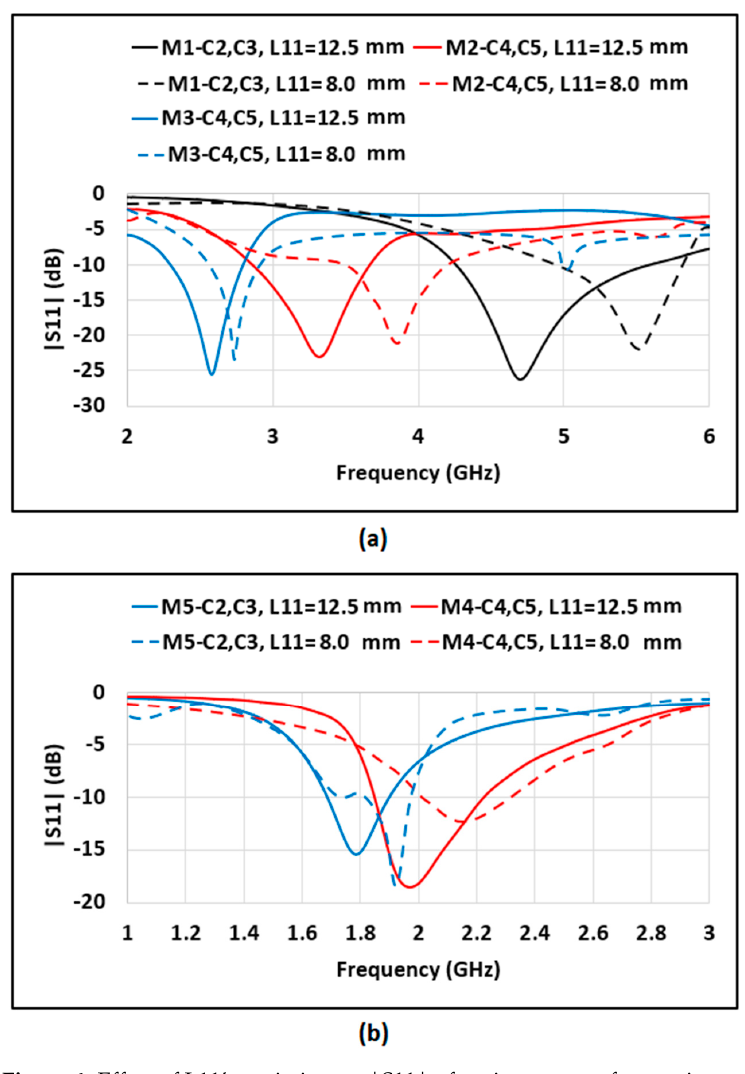
Figure 4. Effect of L11’s variation on |S11| of various cases of operating modes ( a , b ).